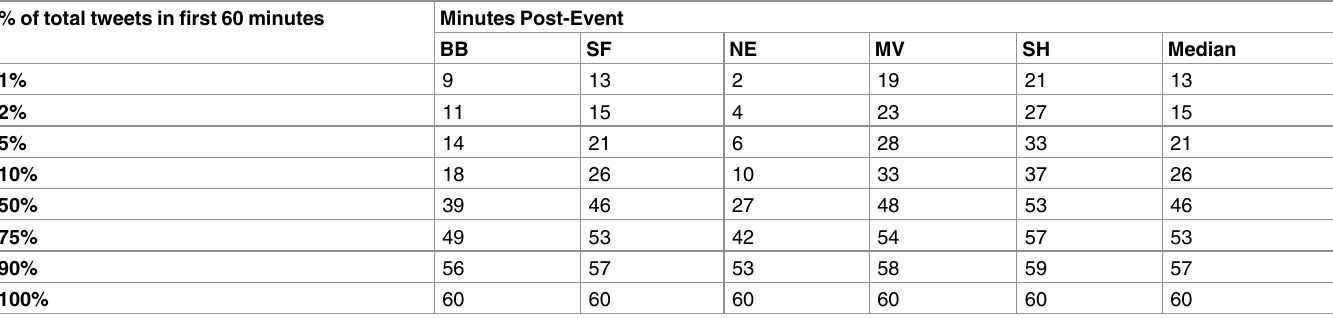
Table 3. Tweet thresholds in the first 60 minutes following each event. % of total tweets in first 60